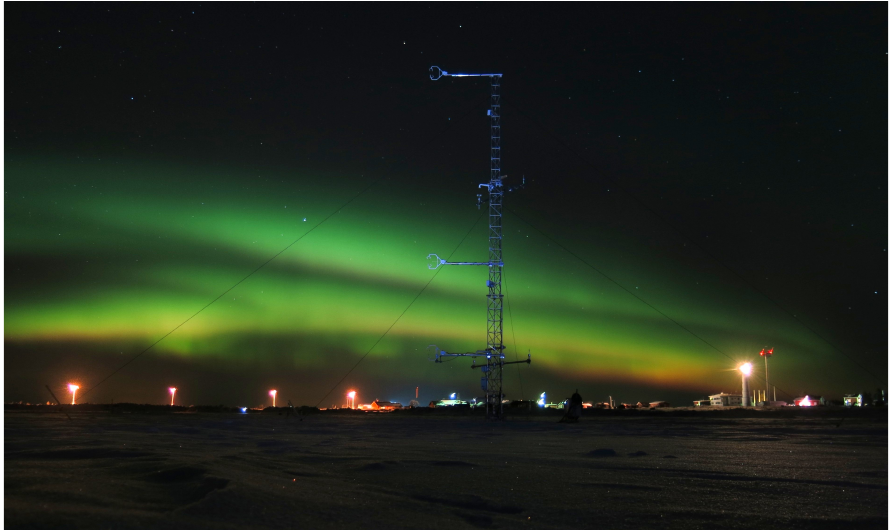
Figure 7. Meteorological measurement tower during the Hailuoto-II campaign. Viewing direction is north-north-east towards the harbour and the village Marjaniemi. The picture was taken by Kristine Flacké